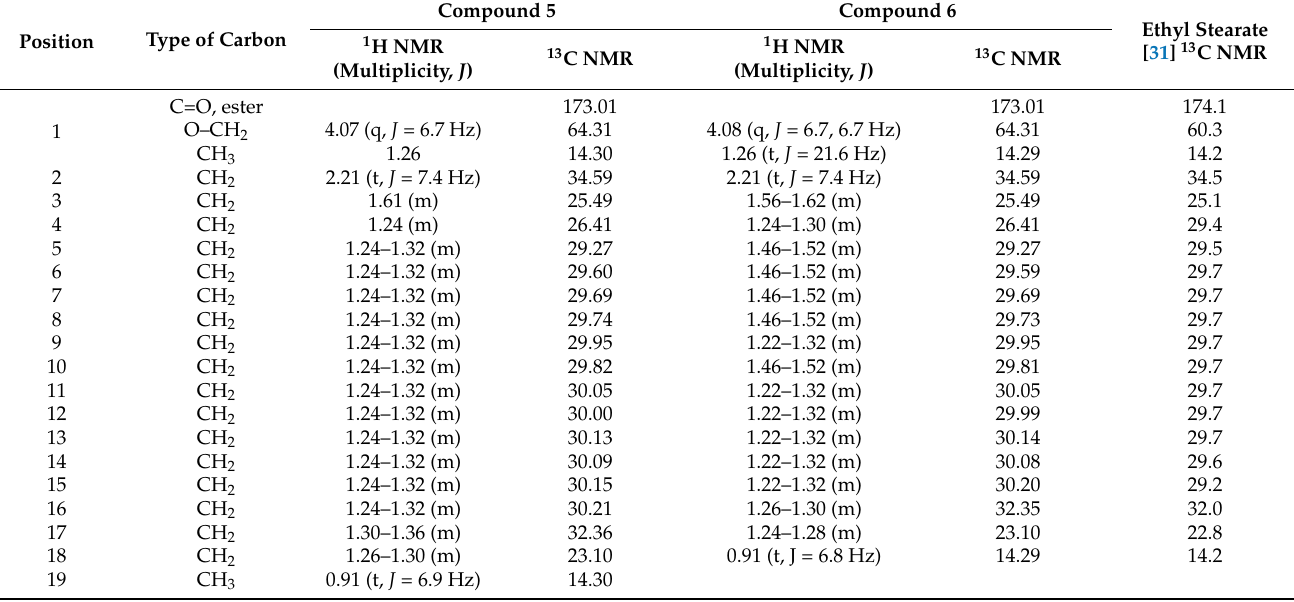
Table 4. 1 H- and 13 C NMR Spectral Data Assignment of Compounds 5 and 6 Isolated from C. sexangularis